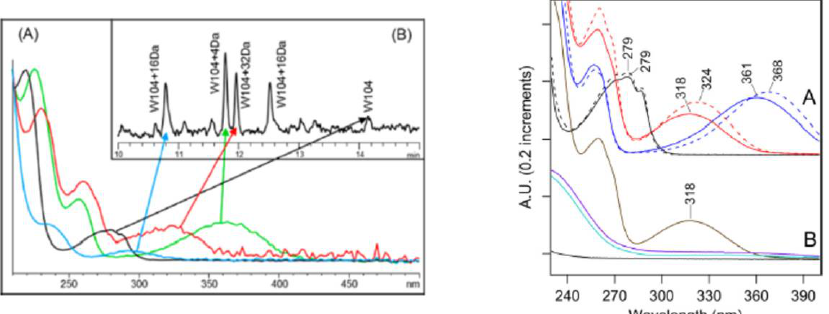
Figure 4. (Left panel, A ) UV absorption spectra of the peptide containing non oxidized Trp (Black) and oxidized Trp. Kyn (+4 Da, green), NFK (+32 Da, red) and hydroxyl tryptophan (+16 Da, blue) from forced degraded mAb sample (Left panel, B ) peptide elution profile covering these peptides (A310 nm). (Right panel A ) Absorption spectra of 40 µ M tryptophan in water (black, solid line) and in 50% acetonitrile, 0.1% TFA (black, dashed line). Spectra of 40 µ M kynurenine in water (blue, solid line) and in 50%acetonitrile, 0.1% TFA (blue, dashed line). Spectra of 40 µ M NFK in water (red, solid line) and in 50% acetonitrile, 0.1% TFA (red, dashed line), Values shown on each curve indicate wavelength at local absorbance maximum. (Right panel B ) Spectra of a mixture of 40 µ M NFK and 160 µ M BSA (brown) and when treated with 400 µ M NaBH 4 in water (cyan). Spectrum of 160 µ M BSA when treated with 400 µ M NaBH 4 in water (black) and spectrum of 40 µ M NFK when treated with 400 µ M NaBH 4 (violet) in water. Reproduced with permission from reference [6,41]. Table 2. Modification of intrinsic fluorescence properties of oxidized tryptophan amino acid, and AGE product with absorbance spectrum extending in the blue region of the visible spectrum. 380 nm